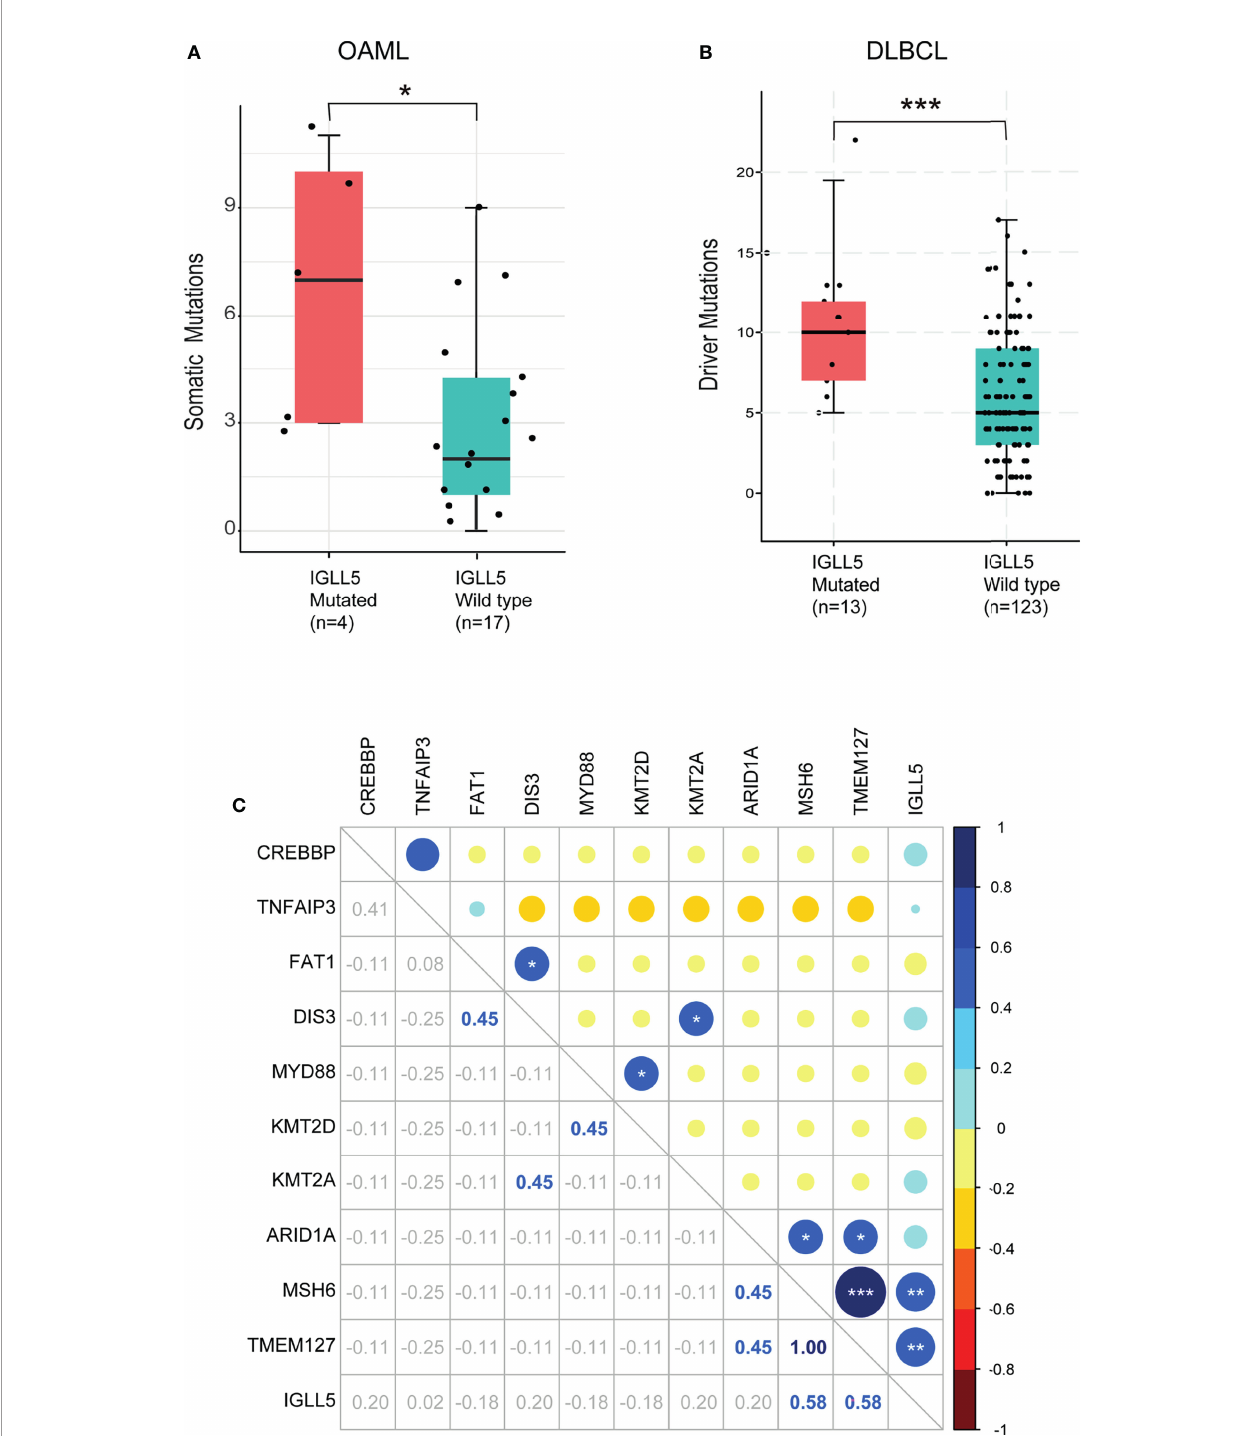
FIGURE 4 | Association of mutant IGLL5 with clinical characteristics. Box plots of comparison of mutation load between tumors with and without mutations in IGLL5 . IGLL5 -mutated tumors presented (A) a signi fi cantly higher median of somatic driver mutations (3 in mutant cases vs . 7 in wildtype cases) in this study and (B) a signi fi cantly higher median of driver mutations (5 in mutant cases vs . 10 in wildtype cases) in data from the TCGA online database. (C) Heatmap shows co- occurrence and mutual exclusivity identi fi ed by WES across mutation types. Numbers indicate Correlation coef fi cients analyzed by the Pearson product-moment correlation coef fi cient. P values were calculated using the Mann-Whitney U-test. TCGA pan-cancer data were obtained from the cBioPortal (https://www.cbioportal. org). (* P < 0.05, ** P < 0.01, *** P <